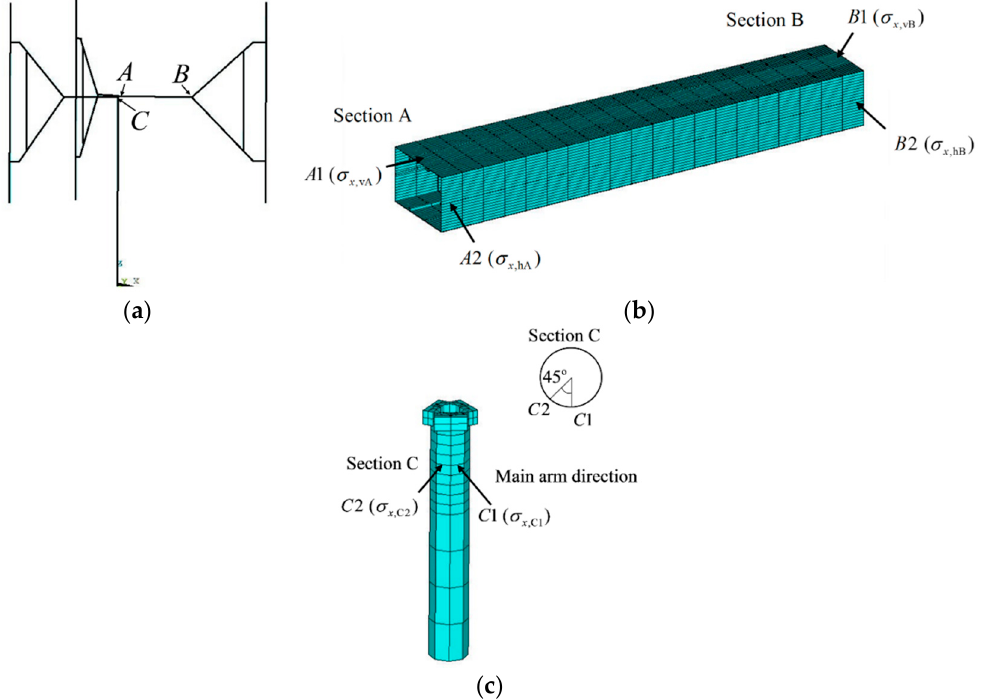
Figure 11. Fatigue-critical locations of the VAWT: ( a ) Critical sections; ( b ) Critical locations on the main arm; ( c ) Critical locations on the shaft.